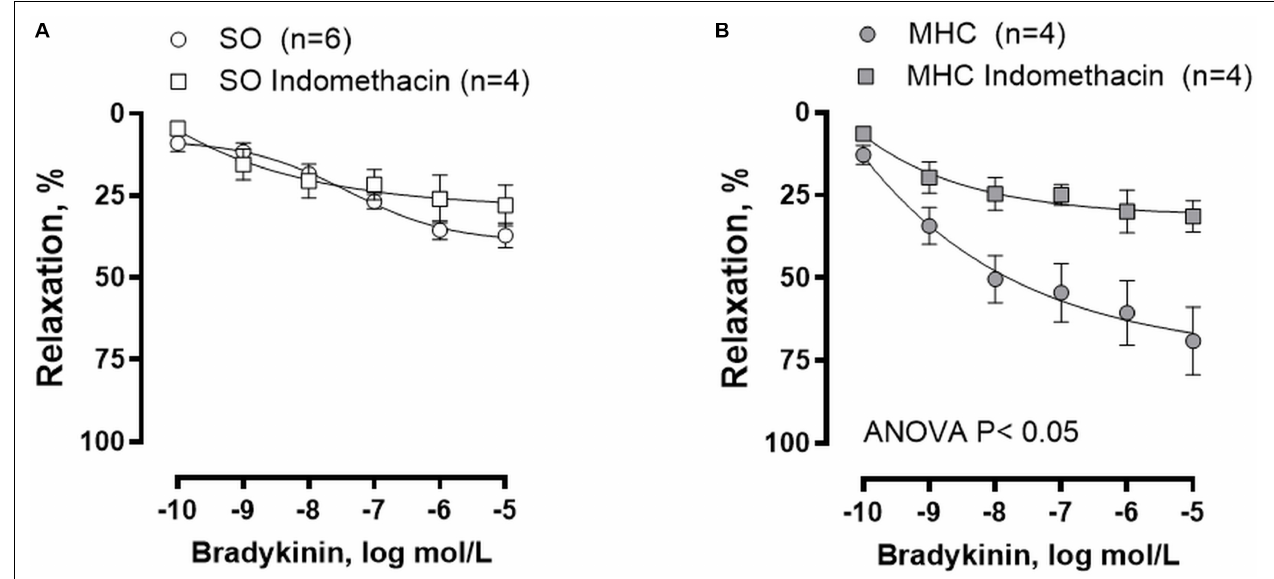
FIGURE 5 | Effect of preincubation with COX inhibitor indomethacin on the concentration-dependent relaxation to bradykinin in rat middle cerebral arteries from Sham-Operated (SO), (A) ; ( n = 4–6 segments from different animals) and microsurgical liver cholestasic (MHC), (B) ; ( n = 4 segments from different animals) rats. Results (mean ± SEM) were expressed as a percentage of the initial contraction elicited by